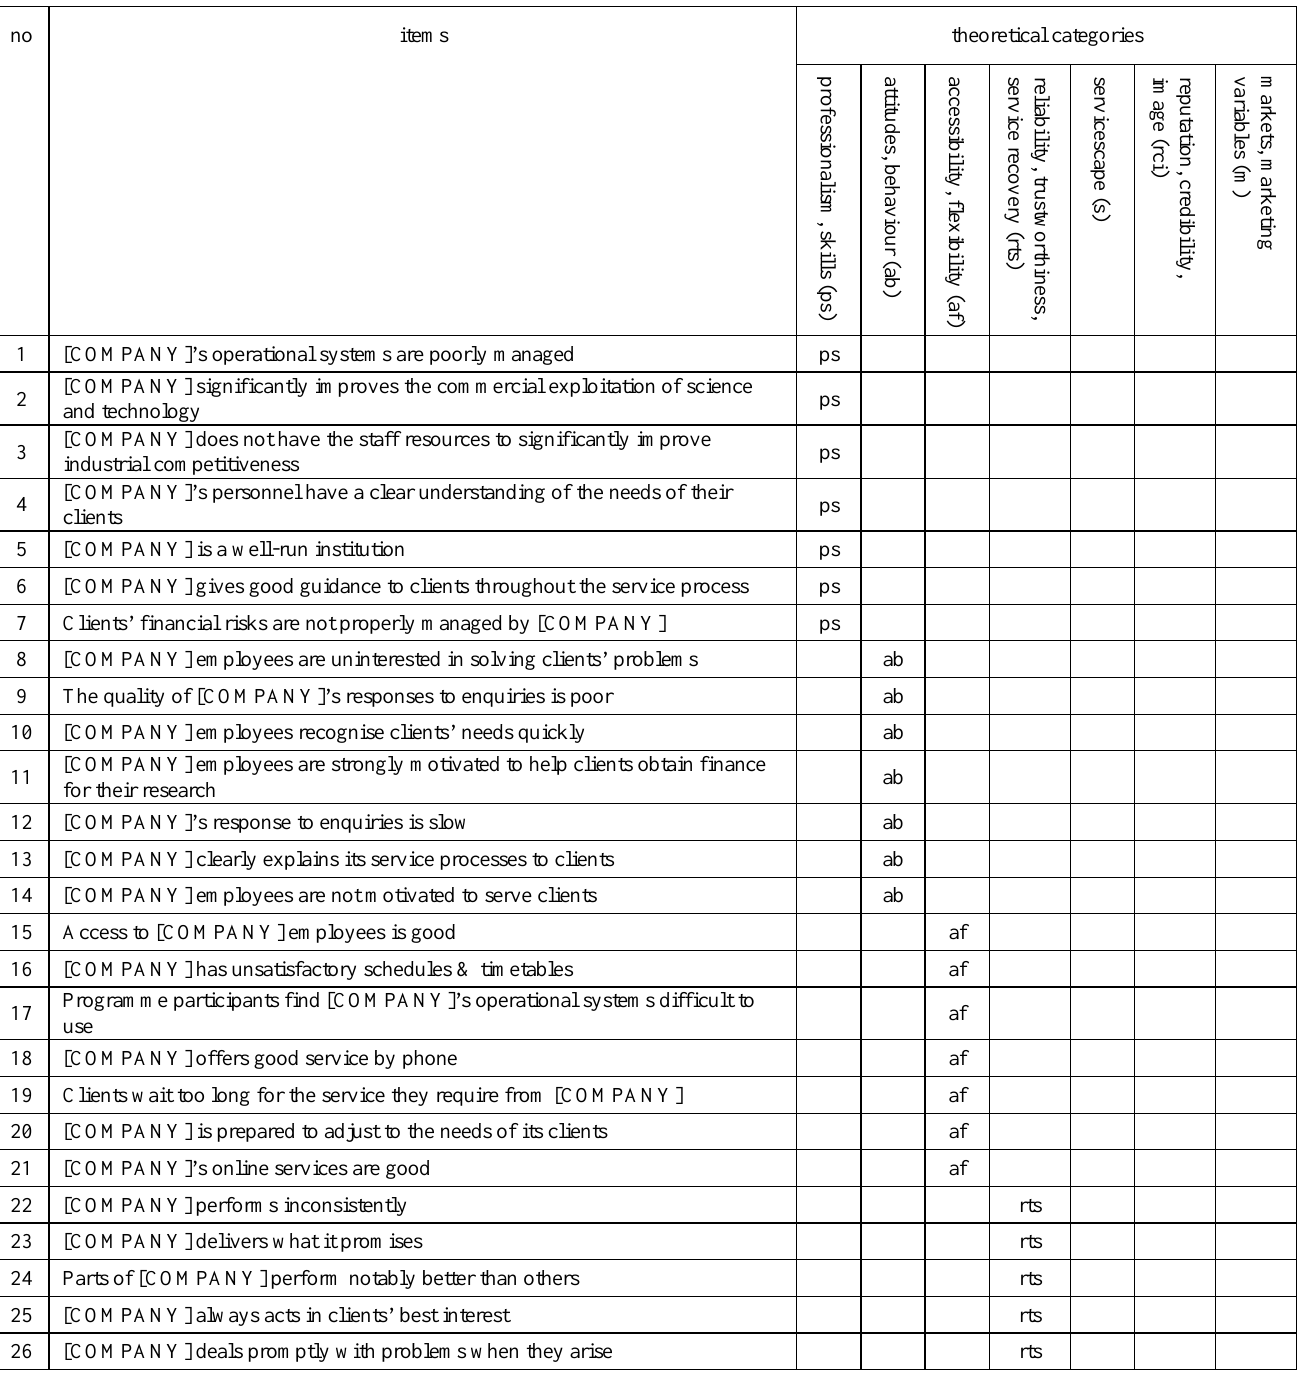
Figure 1: An example of the theoretical levels of an item in the Q sample Table 2: The Q